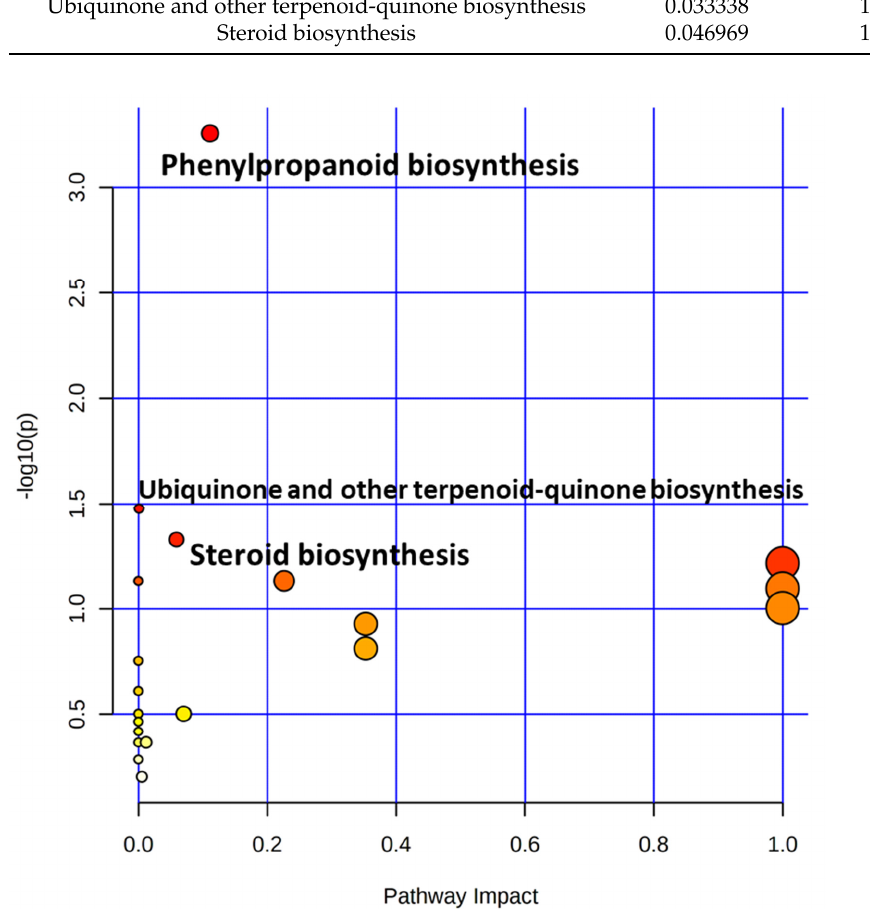
Figure 7. Metabolic pathways differentiating the grains of Mappillai Samba and CBMAS 14065. Each circle represents a metabolic pathway; the red circle indicates a higher impact and the yellow one indicates a lower impact. The size of the circle represents the number of differential metabolites present in the pathway.